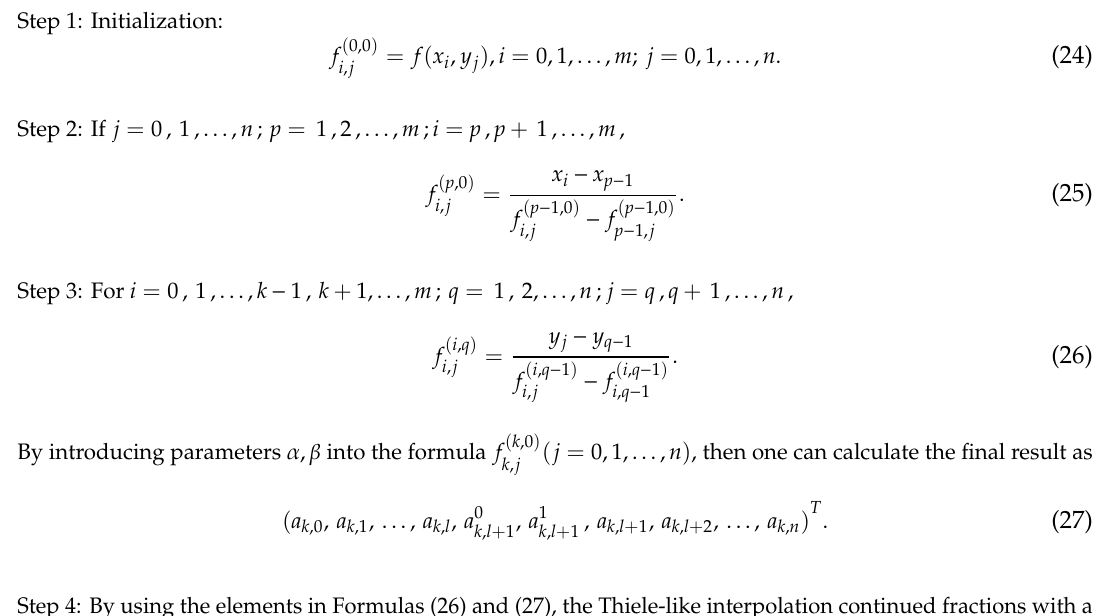
Algorithm 2 Algorithm of the bivariate Thiele-like rational interpolation continued fractions with two